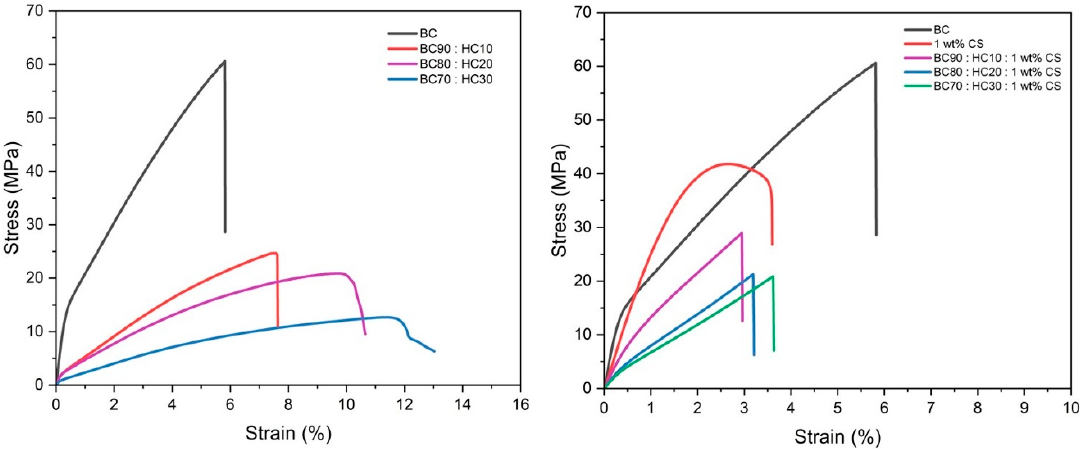
Figure 5. Stress–strain curves of BC film, CS film, BC:HC films, and CS ‐ coated BC:HC films.